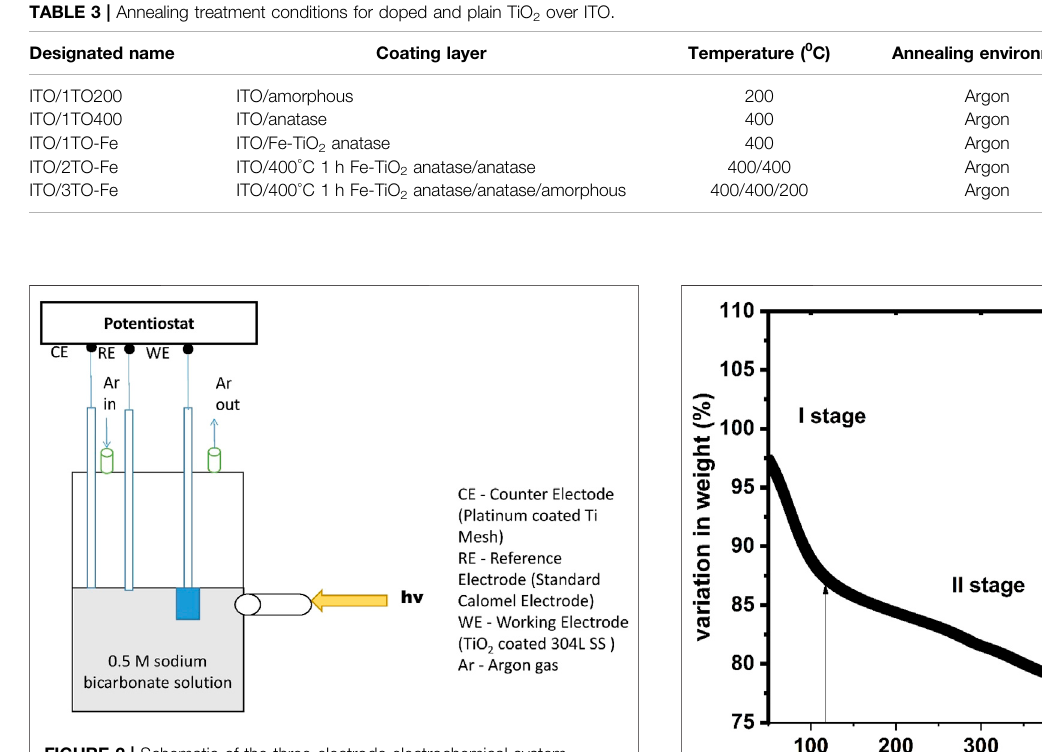
FIGURE 2 | Schematic of the three-electrode electrochemical system with a potentiostat for polarization analyses. A fl at transparent window was installed to provide a designated path for incident